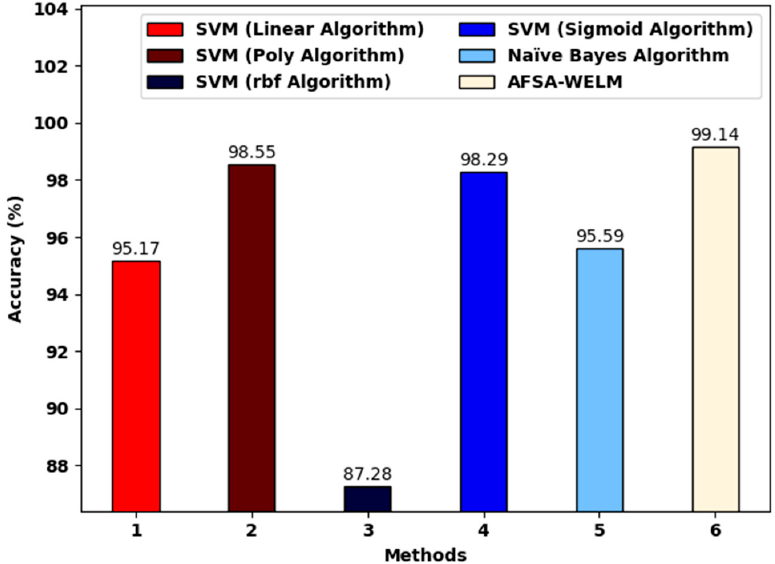
Figure 6. The Acc y analysis of the proposed model and existing Figure 6. The 𝐴𝑐𝑐 (cid:3052) analysis of the proposed model and existing algorithms.